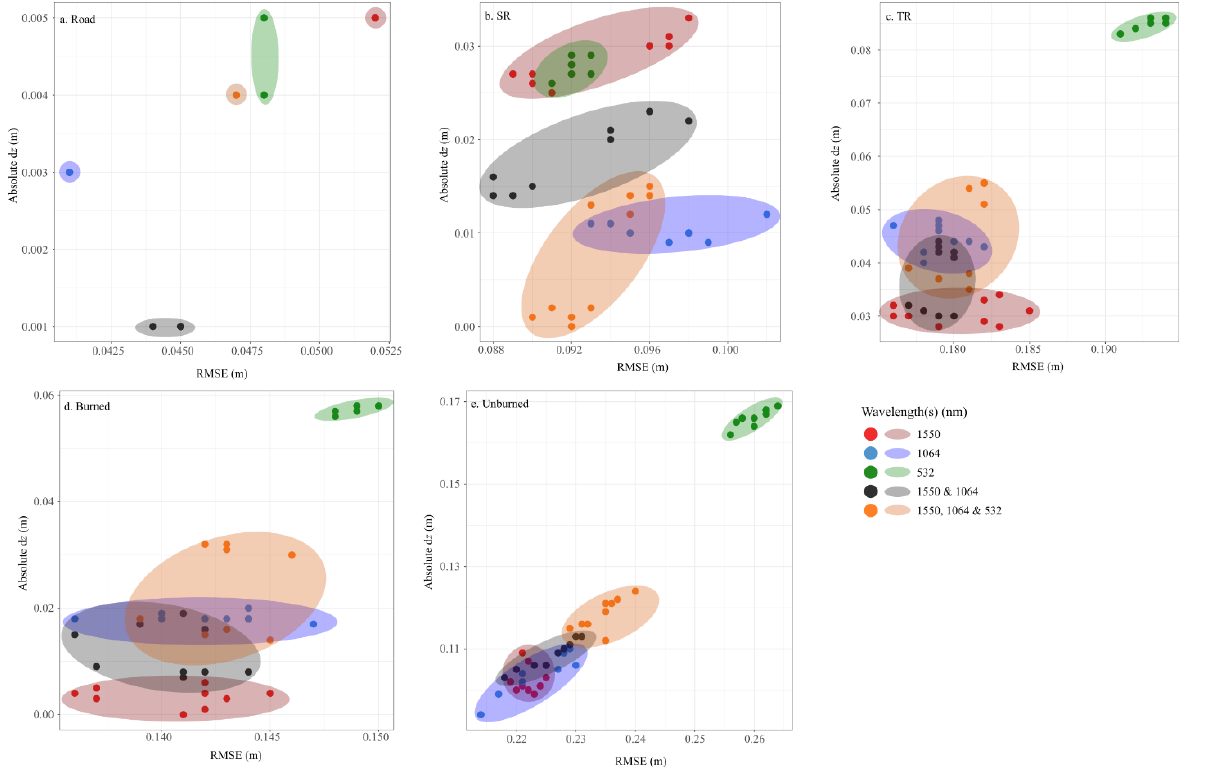
Figure 16. Ground classification results by wavelength along/in: ( a ) roads, ( b ) burned peatlands with short regeneration, ( c ) burned peatlands with tall regeneration, ( d ) all burned peatlands, and ( e ) unburned peatlands two years post-fire. Results were identified using LAStools as determined by lidar channel. Each point represents an iterative parameter set. Note: axis range varies by plot.